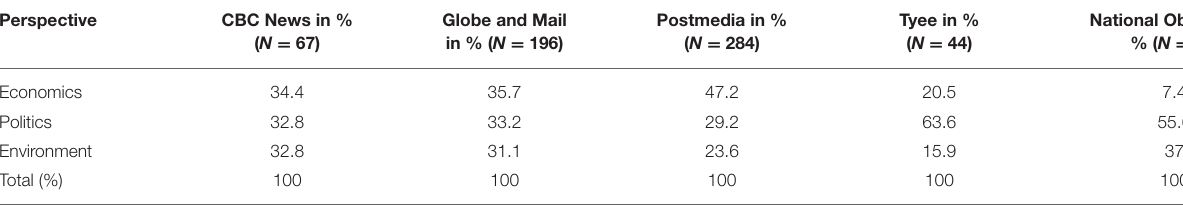
TABLE 6 | Distribution of news items by thematic perspective. Perspective